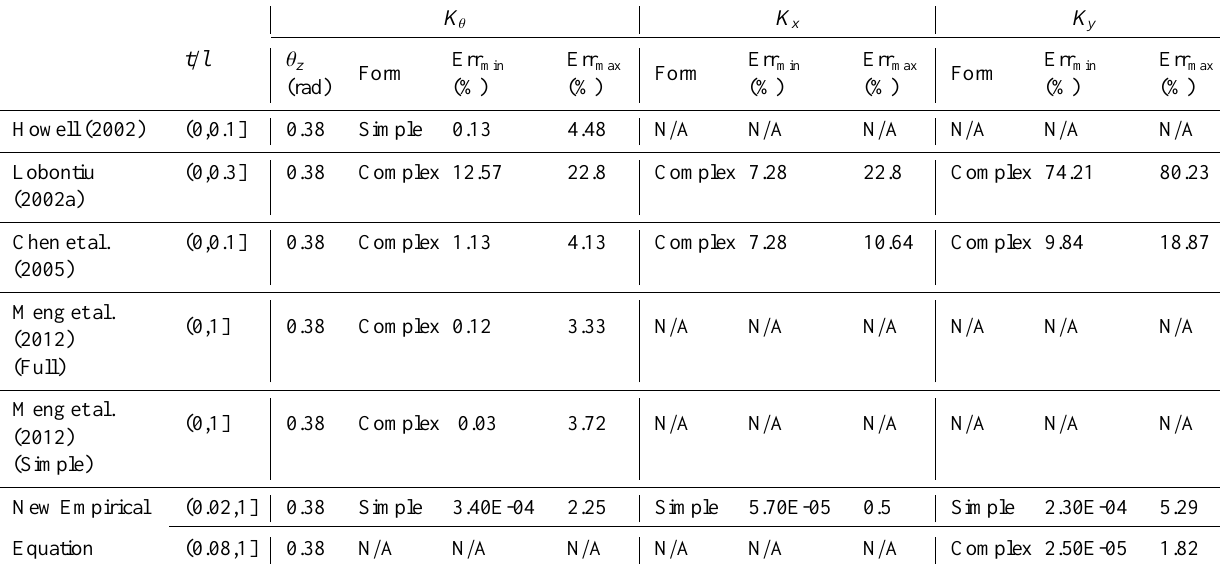
Table 2. Suggested sti ff ness / compliance equations for a particular t / l